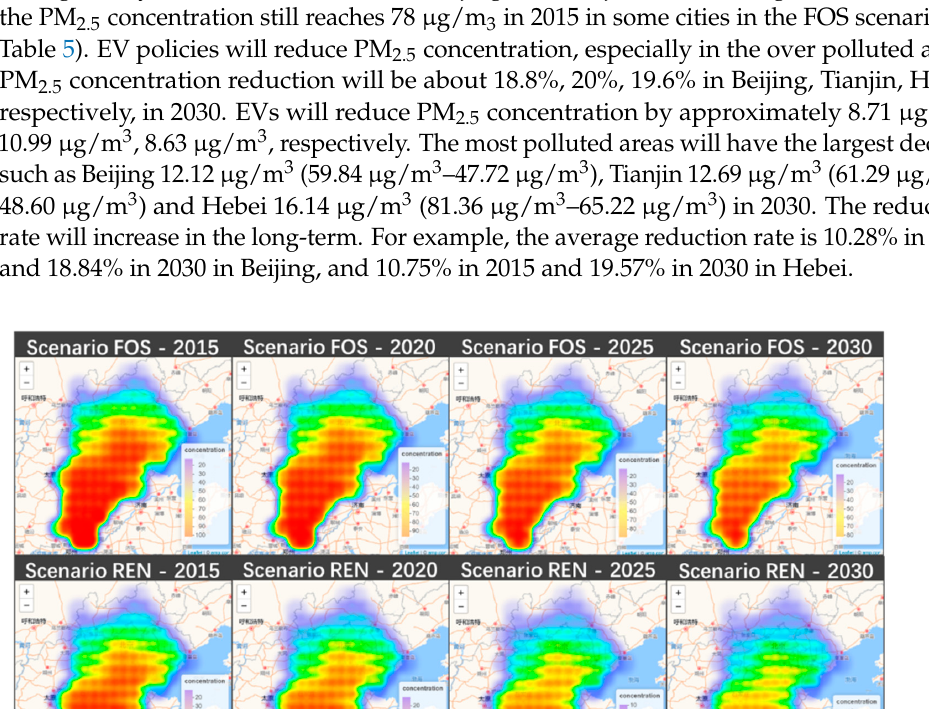
Table 5. Annual average PM 2.5 concentration ( μg/m (cid:2871) ) 1 .